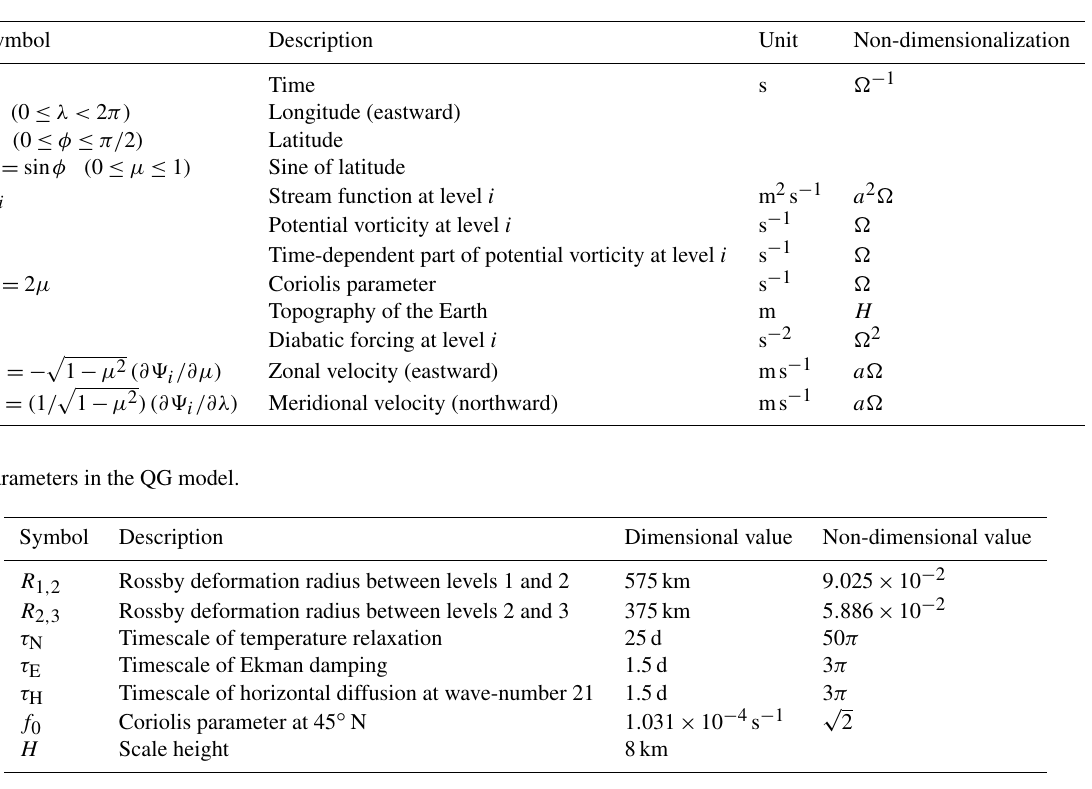
Table 1. Variables and fields in the QG model and their non-dimensionalization with the Earth’s radius a = 6 . 371 × 10 6 m and the angular velocity of the Earth (cid:127) = 7 . 292 × 10 − 5 s − 1 .